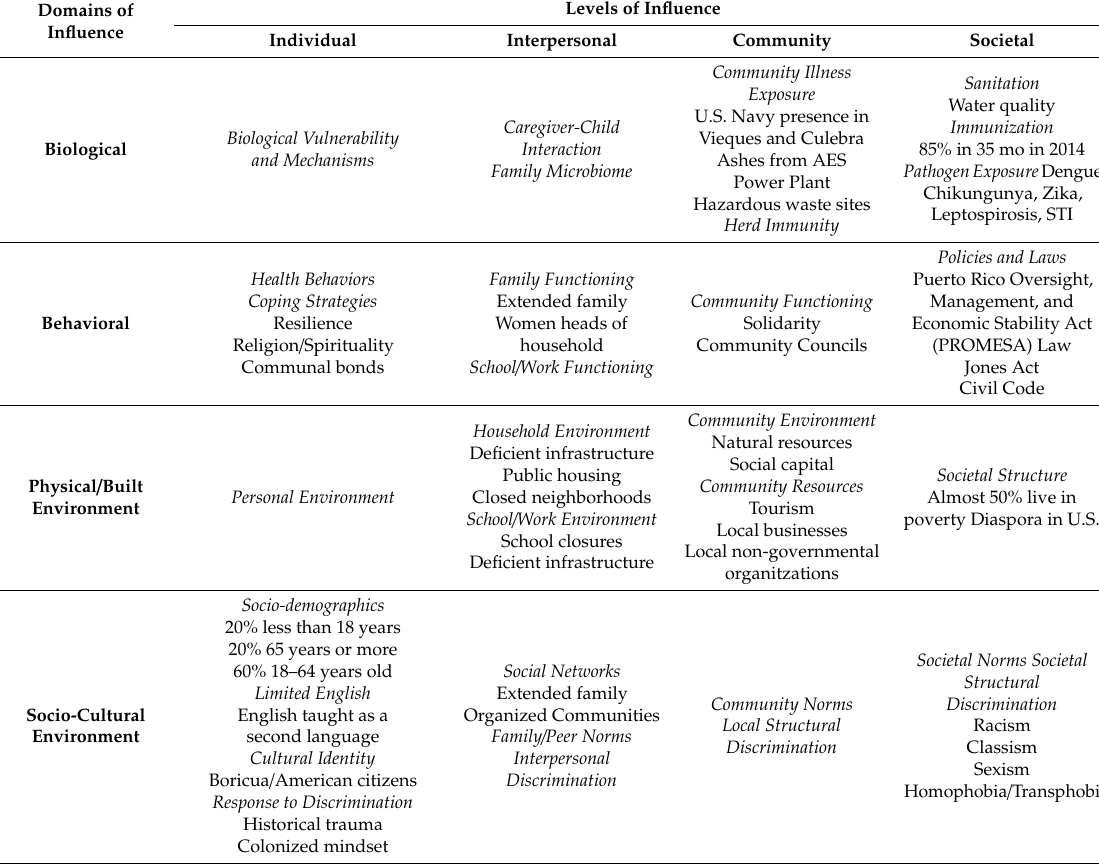
Table 1. National Institute of Minority Health and Health Disparities (NIMHD) Research Framework adapted to reflect historic and socio-cultural influences of the Puerto Rican